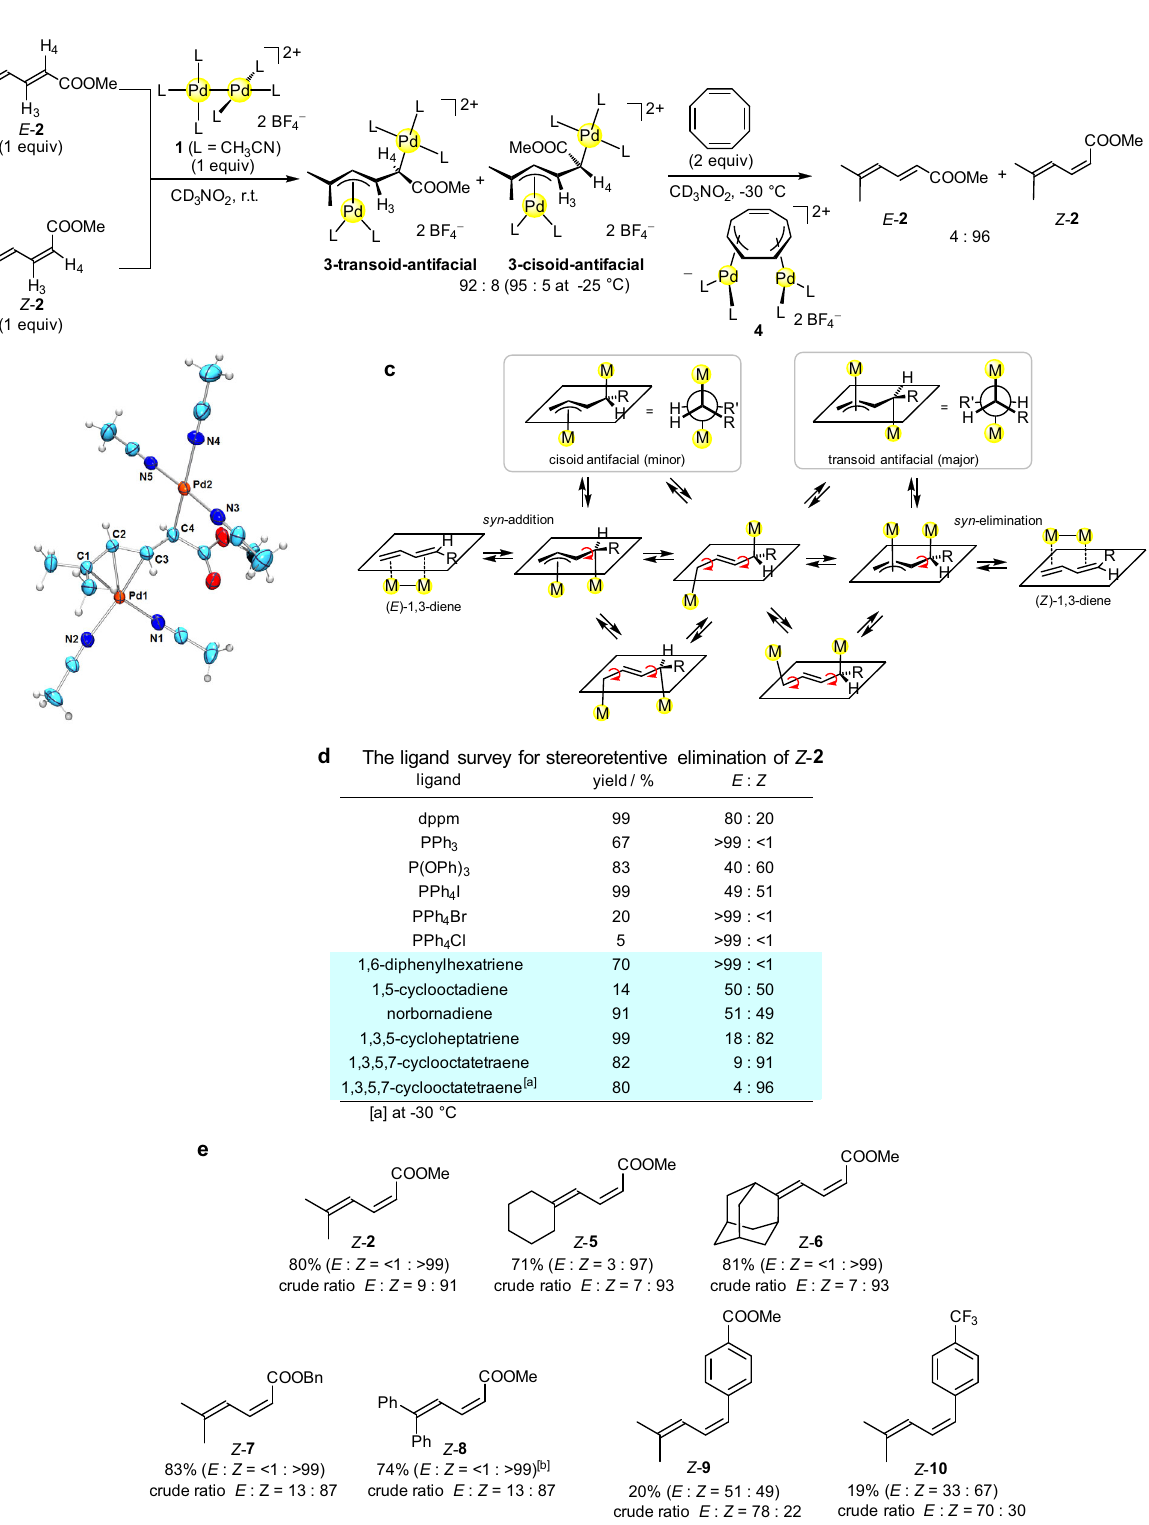
Fig. 2 The dinuclear addition of a Pd I – Pd I moiety to substituted 1,3-dienes. a The dinuclear addition to 5-methylhexa-2,4-dienoate ( 2 ), and subsequent dinuclear elimination giving Z -diene selectively. b ORTEP for 3-transoid-antifacial (30% probability ellipsoids; counteranions are omitted for clarity). c The allyl π – σ – π interconversion for the rapid stereoinversion mechanism. d The ligand survey for stereoretentive elimination of Z - 2 . The reactions were carried out in CD 3 NO 2 at room temperature. dppm = bis(diphenylphosphino)methane. [a] At − 30 °C. e Yields of Z -1,3-dienes after isolation. Typically, the diene was added to a CH 3 NO 2 solution of 1 , and stirred for 30 min. The reaction mixture was cooled to − 30 °C, and then COT was added and the mixture was stirred for 15 min. [b] PPh 4 I was used instead of